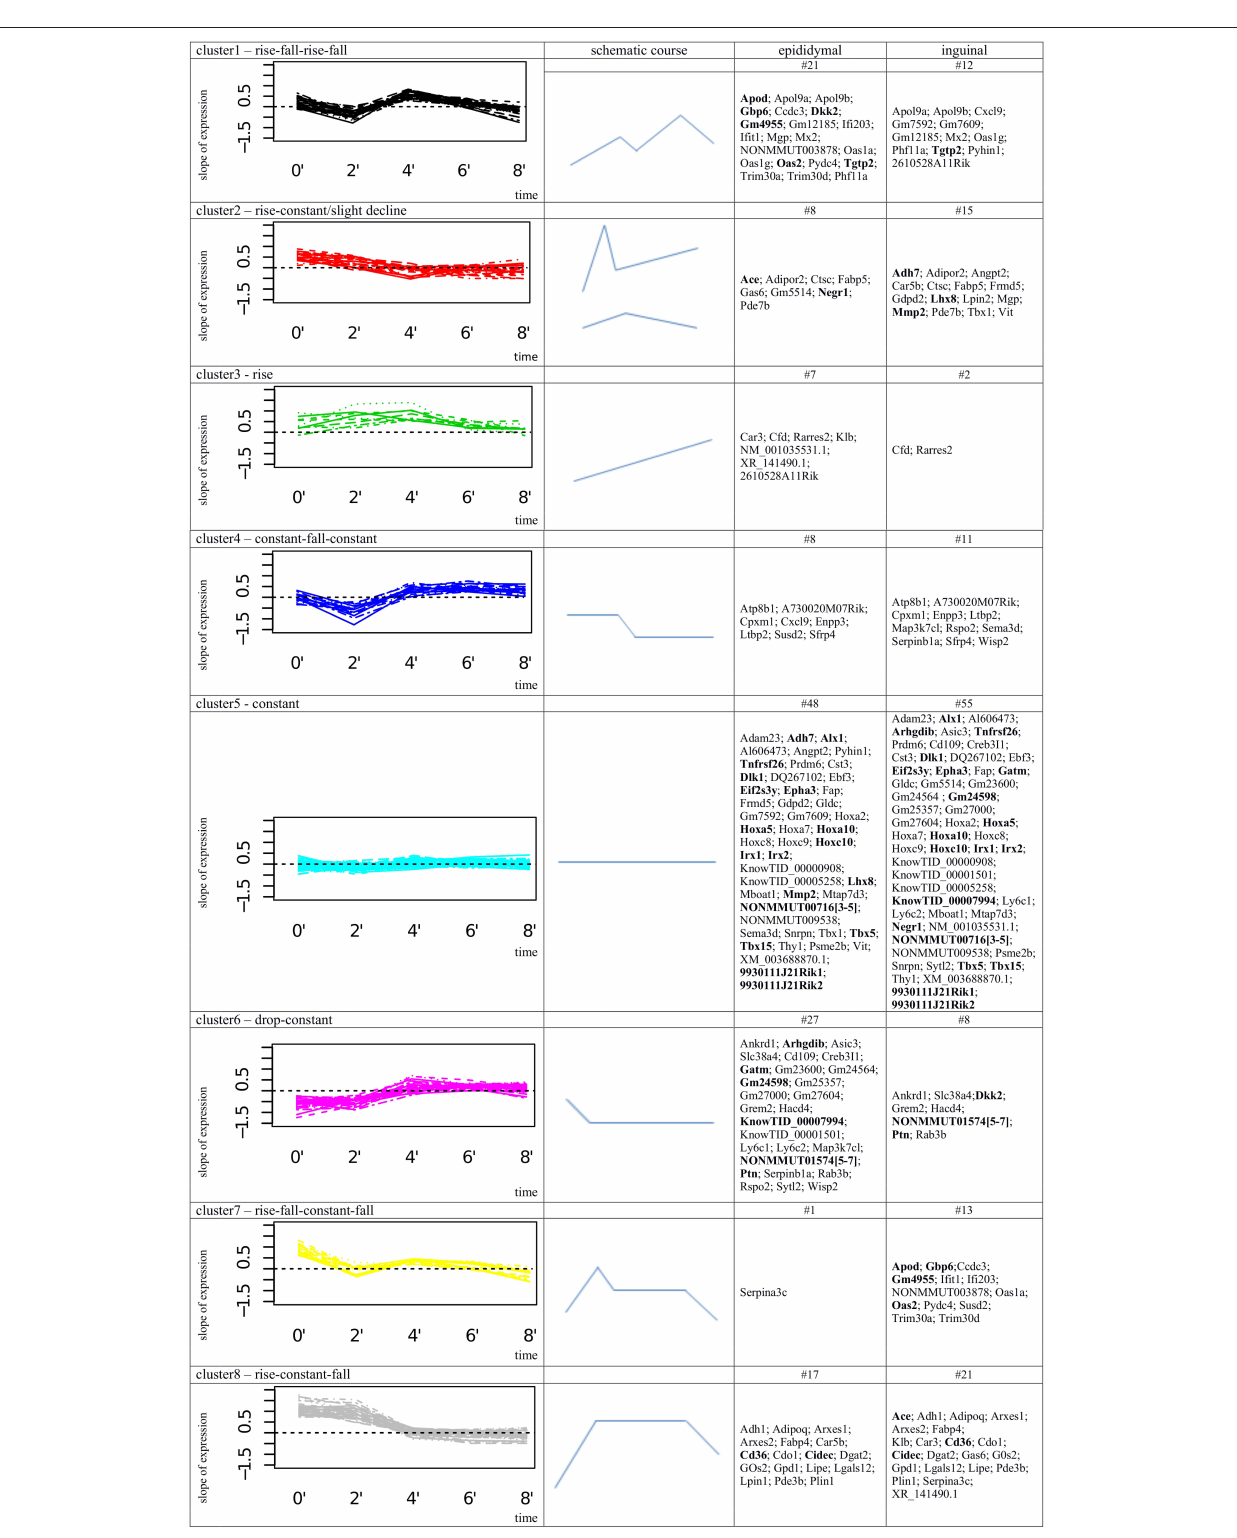
Frontiers in Endocrinology | www.frontiersin.org